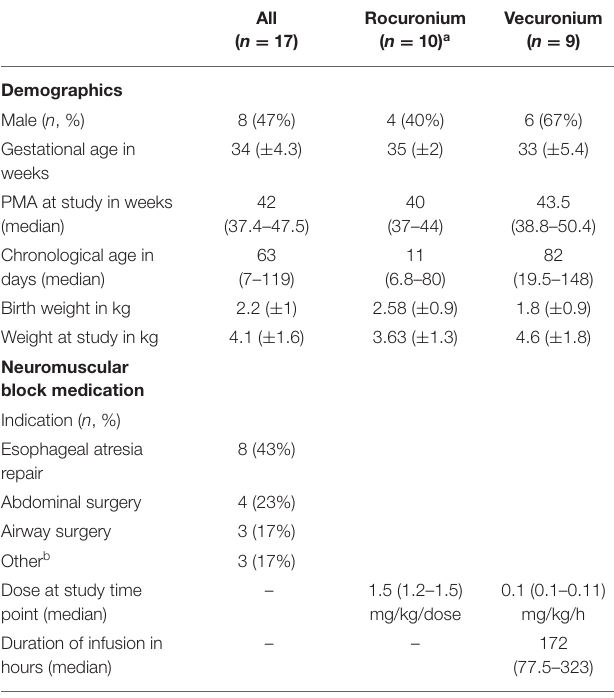
TABLE 1 | Demographics and relevant clinical history.